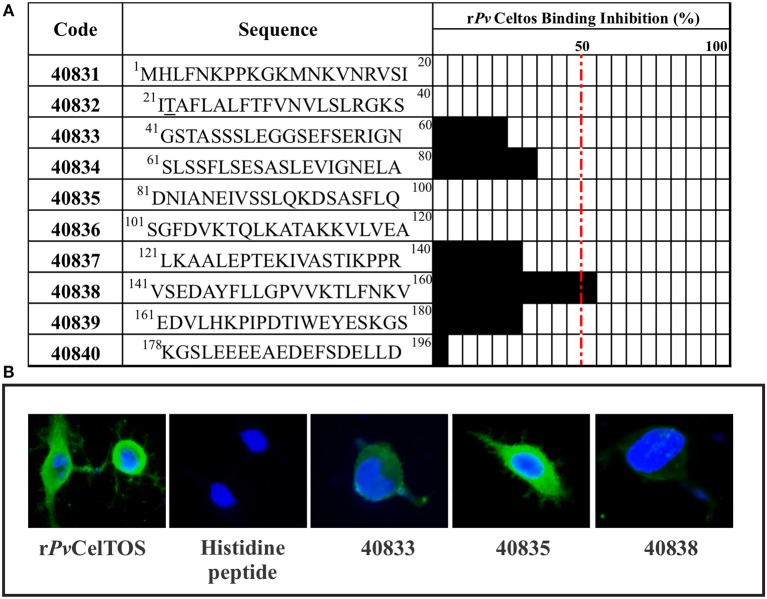
PvCelTOS competition assays. Twenty amino acid-long, non-overlapping peptides covered the length of PvCelTOS were used in the rPvCelTOS HeLa cell binding inhibition assays. The black bars represent the percentage regarding the extent to which each peptide inhibited recombinant protein binding. Peptides which were able to inhibit rPvCelTOS binding coincided with regions where sites under negative selection were observed. Each assay was carried out in triplicate in two independent experiments. Standard deviations were below 5% (A). Competition assays using immunofluorescence. The two most representative peptides (40833 and 40838) were able to reduce PvCelTOS binding compared to just the protein or in the presence of peptide 40835 (B). rPvCelTOS binding to HeLa cell membrane is shown as a green fluorescence pattern whilst blue shows cell nuclei. Competition assays were carried out in triplicate.